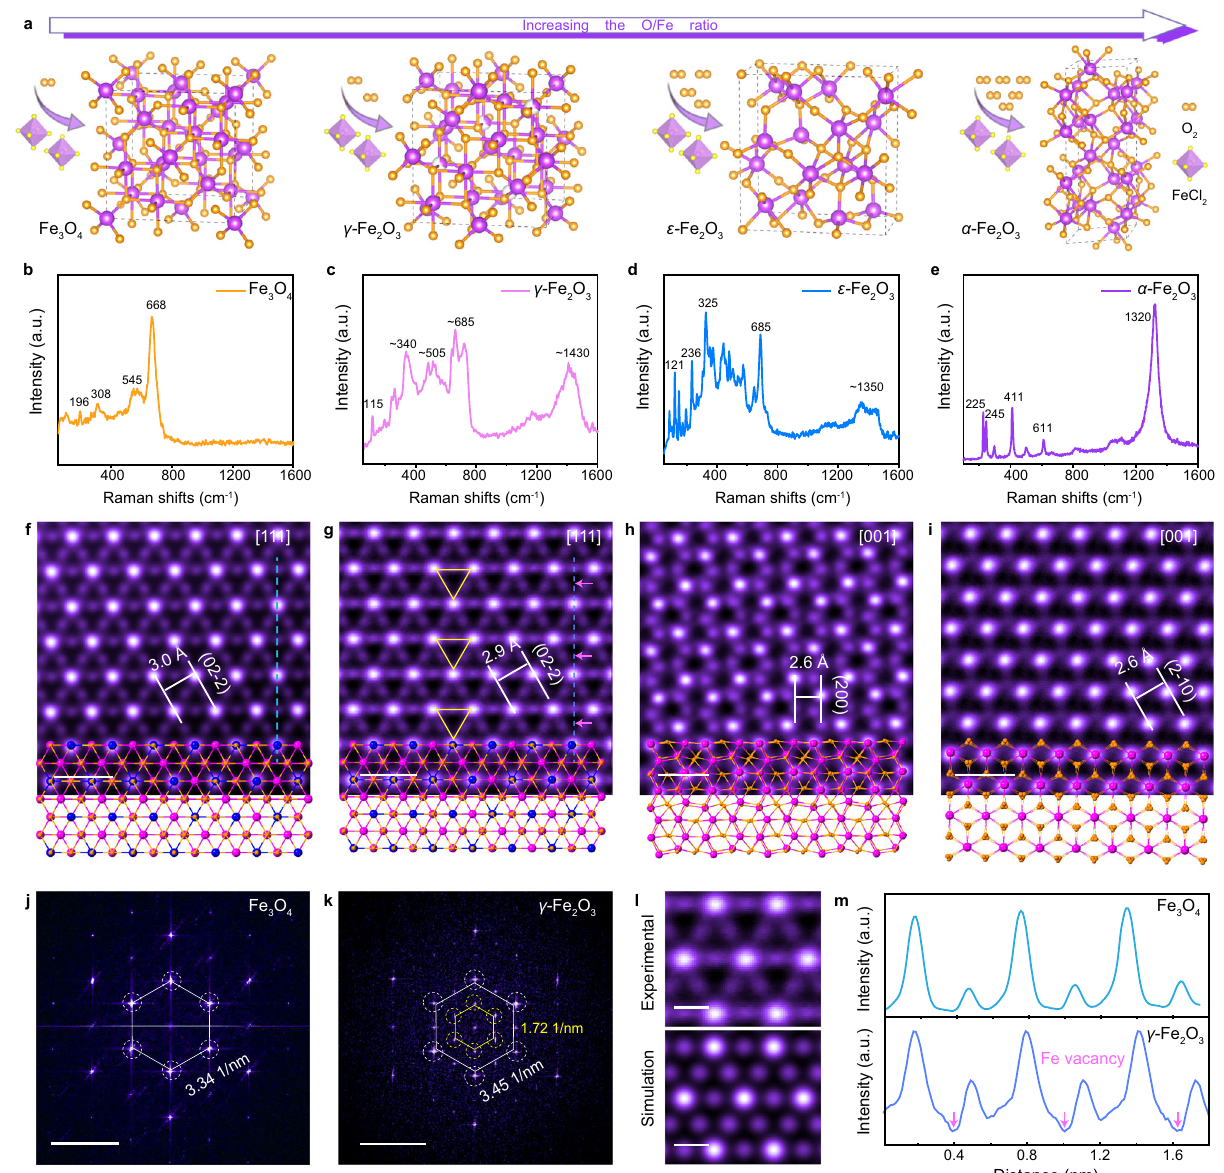
Fig. 3 | Structural characterizations of four iron oxides with different struc- images of Fe 3 O 4 ( f ), γ -Fe 2 O 3 ( g ), ε -Fe 2 O 3 ( h ), and α -Fe 2 O 3 ( i ), respectively, inserted tures. a Structures of four iron oxides. With increasing the O/Fe ratio, Fe 3 O 4 , γ - with projected atomic models. The periodic yellow triangles indicate ordered Fe Fe 2 O 3 , ε -Fe 2 O 3 , and α -Fe 2 O 3 in different structures can be obtained, respectively. octahedral vacancies. The orange, purple, and blue spheres represent O, octahe- dralFe, and tetrahedralFe atoms, respectively. j , k The corresponding fastFourier Double spheres represent O 2 molecules; octahedrons represent FeCl 2 molecules; transform(FFT)patternsofFe 3 O 4 ( j )and γ -Fe 2 O 3 ( k )alongthe[111]direction. l The the orange and purple spheres denote O and Fe atoms, respectively. Dashed rec- enlarged STEM image of γ -Fe 2 O 3 and its corresponding simulated image. m The tangles represent unit cells. b – e Raman vibration modes are indexed to Fe 3 O 4 ( b ), γ -Fe ε -Fe α -Fe corresponding intensity line pro fi les from Fe 3 O 4 and γ -Fe 2 O 3 . The arrows indicate 2 O 3 ( c ), 2 O 3 ( d ), and 2 O 3 ( e ), respectively. Raman spectra of four iron oxidesaretotallydifferent,andthemainpeaksareindicatedinthe fi gures. f – i Top- Fe vacancies. Scale bars: f – i 0.5nm; j , k 1/5nm; l view scanning transmission electron microscopy-annular dark- fi eld (STEM-ADF)